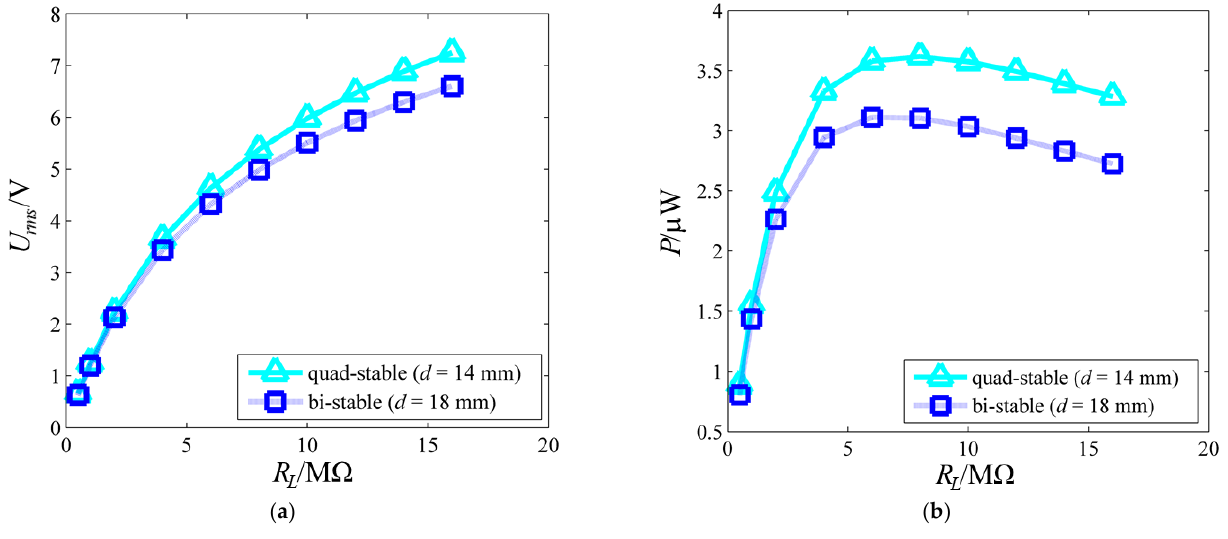
Figure 6. Estimated voltage and power varying with resistance load R L under the quad-stable and bi-stable structural parameters when a Arms = 1.6 g: ( a ) U rms − R L curves; ( b ) P − R L